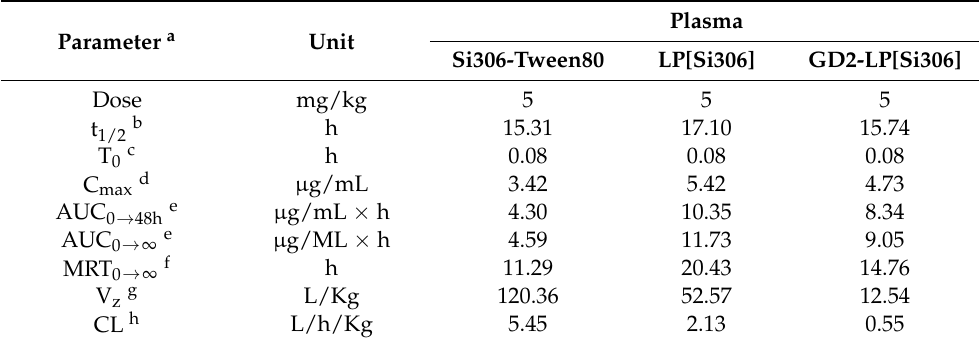
Table 4. Plasma PK parameters of Si306, either free (Si306-Tween80) or encapsulated into untargeted and GD2-targeted liposomes (LP[Si306] and GD2-LP[Si306], respectively) after i.v. administration of a single dose of 5 mg/kg in healthy mice. Parameter a